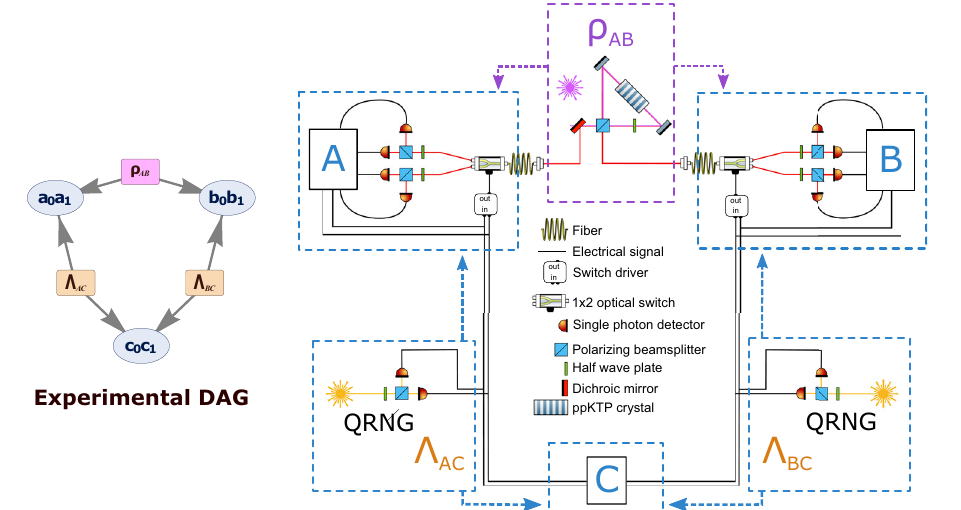
Fig. 2 | Experimental implementation of the triangle network. The source ρ AB generates polarization-entangled photon pairs in the singlet state ∣ Ψ (cid:4) i , by pump- ing with a continuous wave UV laser a periodically poled potassium titanyl phos- phate (ppKTP) crystal. Conversely, Λ AC ( Λ BC ) produces classically correlated states ð ∣ 00 i 00 h ∣ + ∣ 11 i 11 h ∣ Þ = 2 obtained by splitting the output signal of two single-photon avalanchephotodiodessubjectedtoenvironmentallightnoise.InnodesAandB,to implement the measurements needed to reconstruct the probability distribution p ( a , b , c ), the photons from the source ρ AB are collected by the input single-mode fi ber (SMF) of a 5ns rise-time optical switch. In Fritz-like distributions, the mea- surementresult a 0 ( b 0 )onpartofthesource Λ AC ( Λ BC )determinestheobservableto